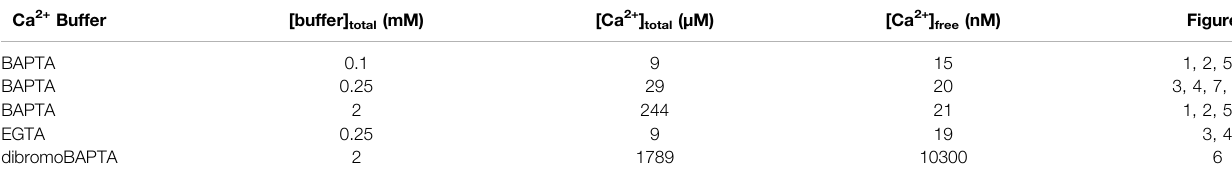
TABLE 1 | Ca 2+ buffering in the internal solutions